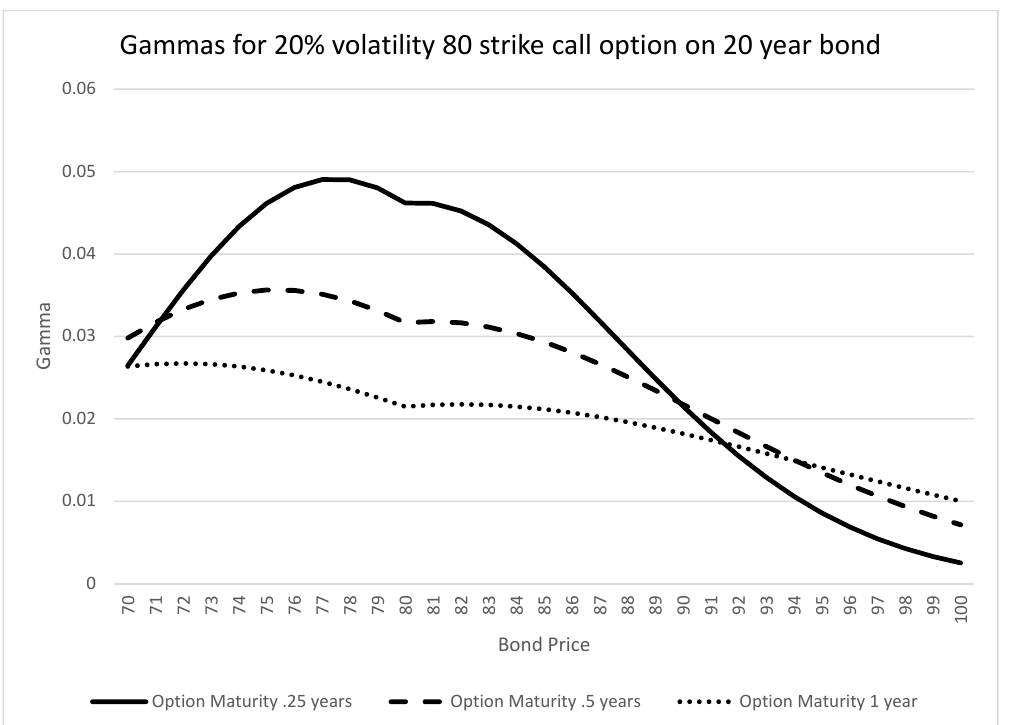
Figure 3. PTP gammas at different option maturities.